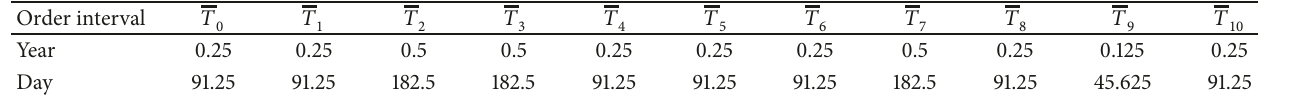
Table 5: A power-of-two policy for the primal